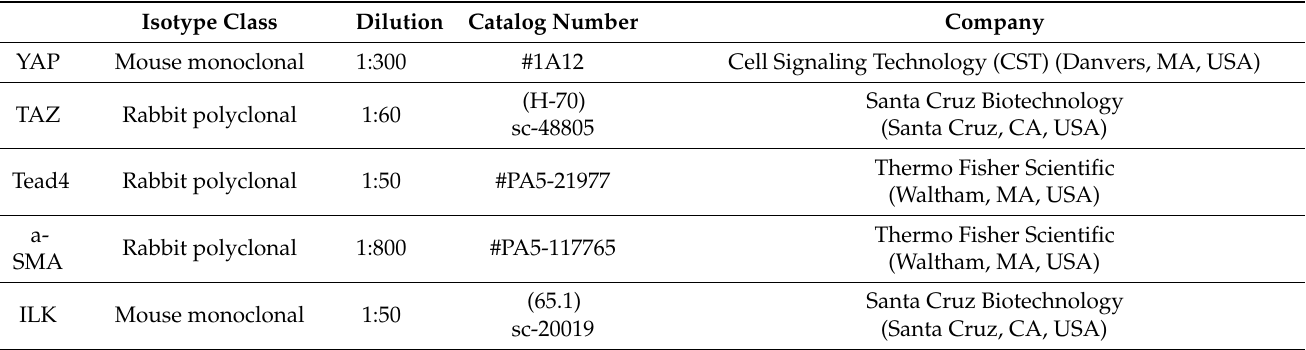
Table 1. Antibodies used in